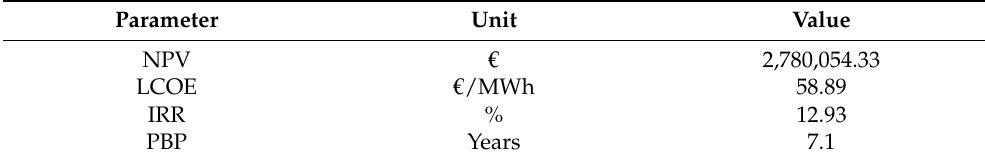
Table 8. Financial parameters of the PV plant.